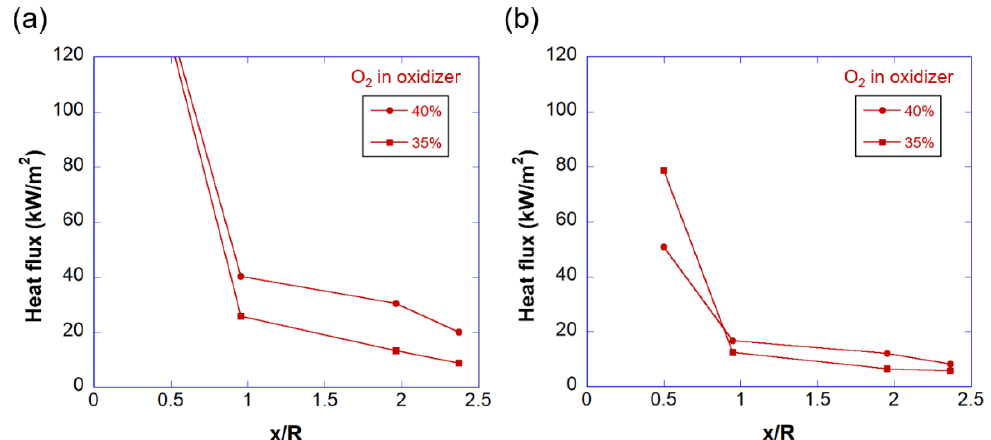
Figure 10. Heat flux from the oxy-fuel FGR flame to the combustion chamber wall for different O 2 concentrations in the oxidizer for ( a ) 100% and ( b ) 50% loads.